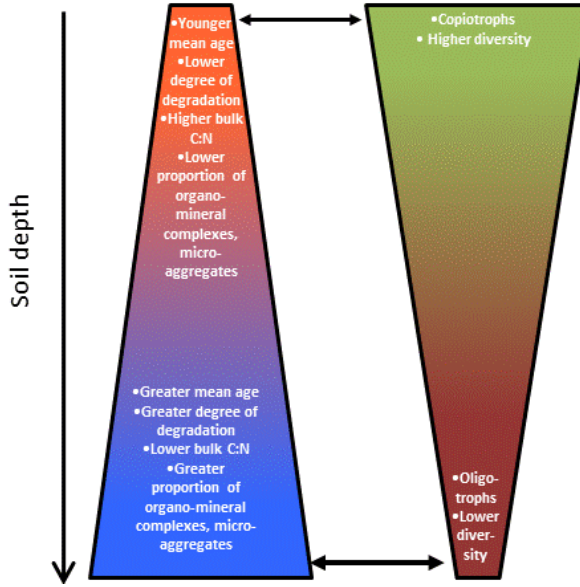
Figure 2. Depiction of parameters describing drivers of SOM decay and retention with depth. Salient physical and chemical features are described on the left, and microbial features on the right. Key fea- tures both resulting from and driving patterns of SOM decay are the mean age of SOM and its associated degree of degradation and C:N ratio, and the degree to which it forms organo-mineral complexes and micro- vs. macroaggregates. All of these except bulk C:N are typically are enhanced with depth. A greater mean residence time is often associated with a greater degree of microbial processing of that material, hence the greater degree of degradation. When coupled with the greater amount of organo-mineral complexes that form with depth, these features drive more energy intensive SOM decay at depth, increasing the activation energy ( E a ) of decay and associated temperature sensitivity of decay. In turn, these physical and chemical changes with depth govern the diversity, physiology, and functional guild of microbial groups in shallow vs. deep soil horizons. The thicker arrow at depth represents likely greater inter- action strength in deep soil horizons among energy availability in substrates, temperature sensitivity, and microbial physiology, given the generally greater E a and lower energy available at depth. Im- portantly, the microbial community can serve as both an agent of decay and of production of SOM compounds with apparently long residence times; this concept has only recently been explored in the soil